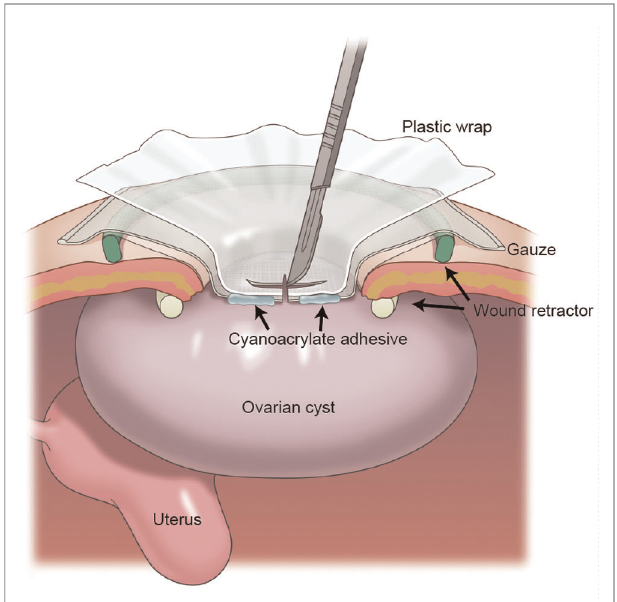
FIGURE 1 | Illustration of the modi fi ed leak-proof puncture technique for the aspiration of giant ovarian cysts. This illustration shows a cross-section of the modi fi ed leak-proof puncture technique for fl uid aspiration of giant ovarian cysts. A wound retractor is attached to the abdominal small incision, and a plastic wrap and gauze are mounted to the cyst instantly using cyanoacrylate adhesive. After the mounting process, the cyst wall is cut and the cyst fl uid is aspirated over the